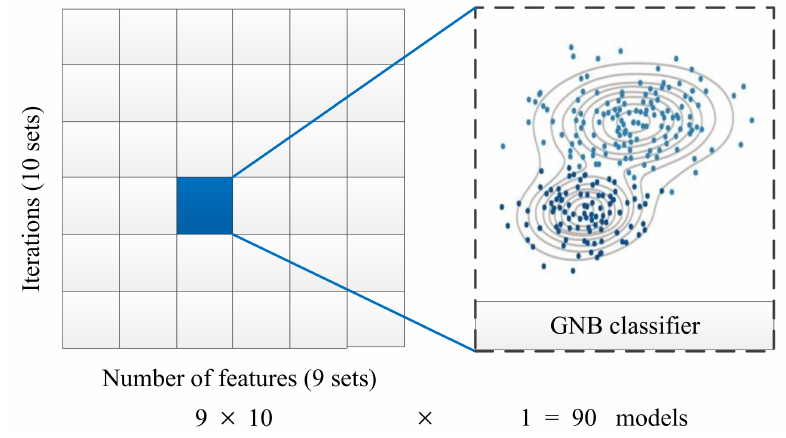
Figure 8. The process of selecting the number of features and iterations.